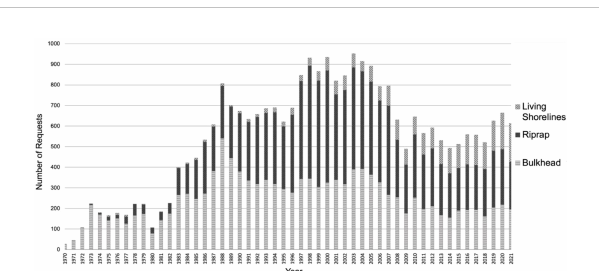
FIGURE 2 Shoreline modi fi cation permit applied for in Virginia, from 1970- 2021 Virginia shoreline modi fi cation permits that were applied for in Virginia, since 1970. The horizonal stripped pattern is the bulkhead permit applications, the dark solid color is the riprap permit applications, and the diagonal stripped pattern is the living shoreline permit applications Data source: Center for Coastal Resources Management Tidal Shoreline Permit Database, (CCRM,